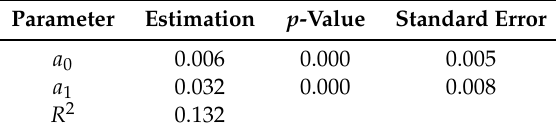
Table 1. Estimation results of Equation (19).